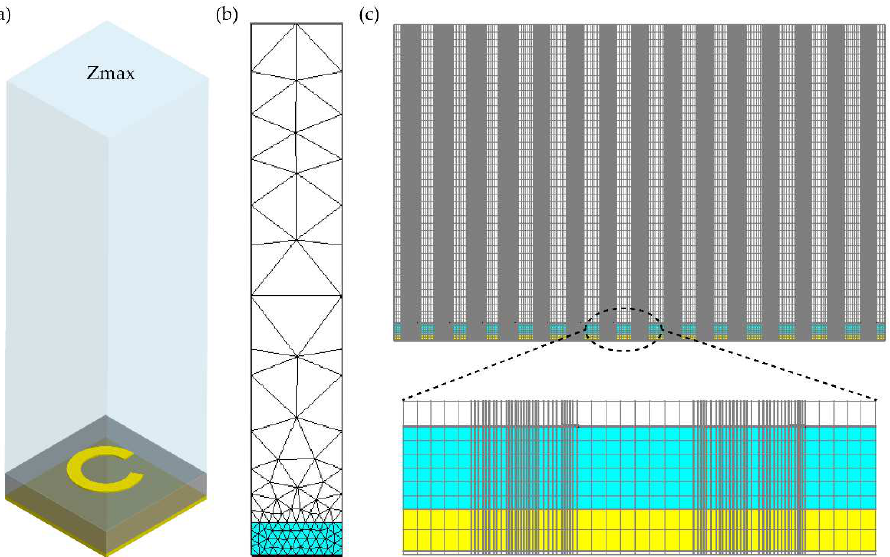
Figure A1. Simulation set-ups show in ( a ) the metallic ground plane, GST, C-shape split ring and vacuum domains, ( b ) the meshes used in the simulations of unit cell, and ( c ) the meshes sets in the whole tunable anomalous beam deflector and its mesh view in xoz plane.